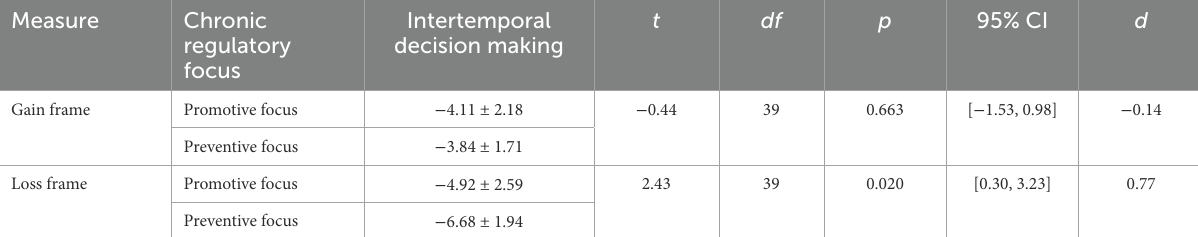
TABLE 4 An independent sample t -test for intertemporal decision making between promotive focus and preventive focus in the condition of upward social comparison.